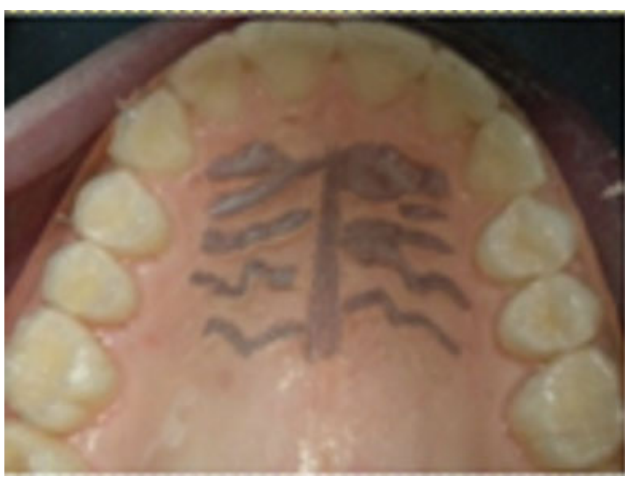
Fig. 5 - Superimposition - photograph and cast with highlighted palatal rugae. Table 2 - Classification of palatal rugae and dental arches. Araraquara, Digital Photograph Code